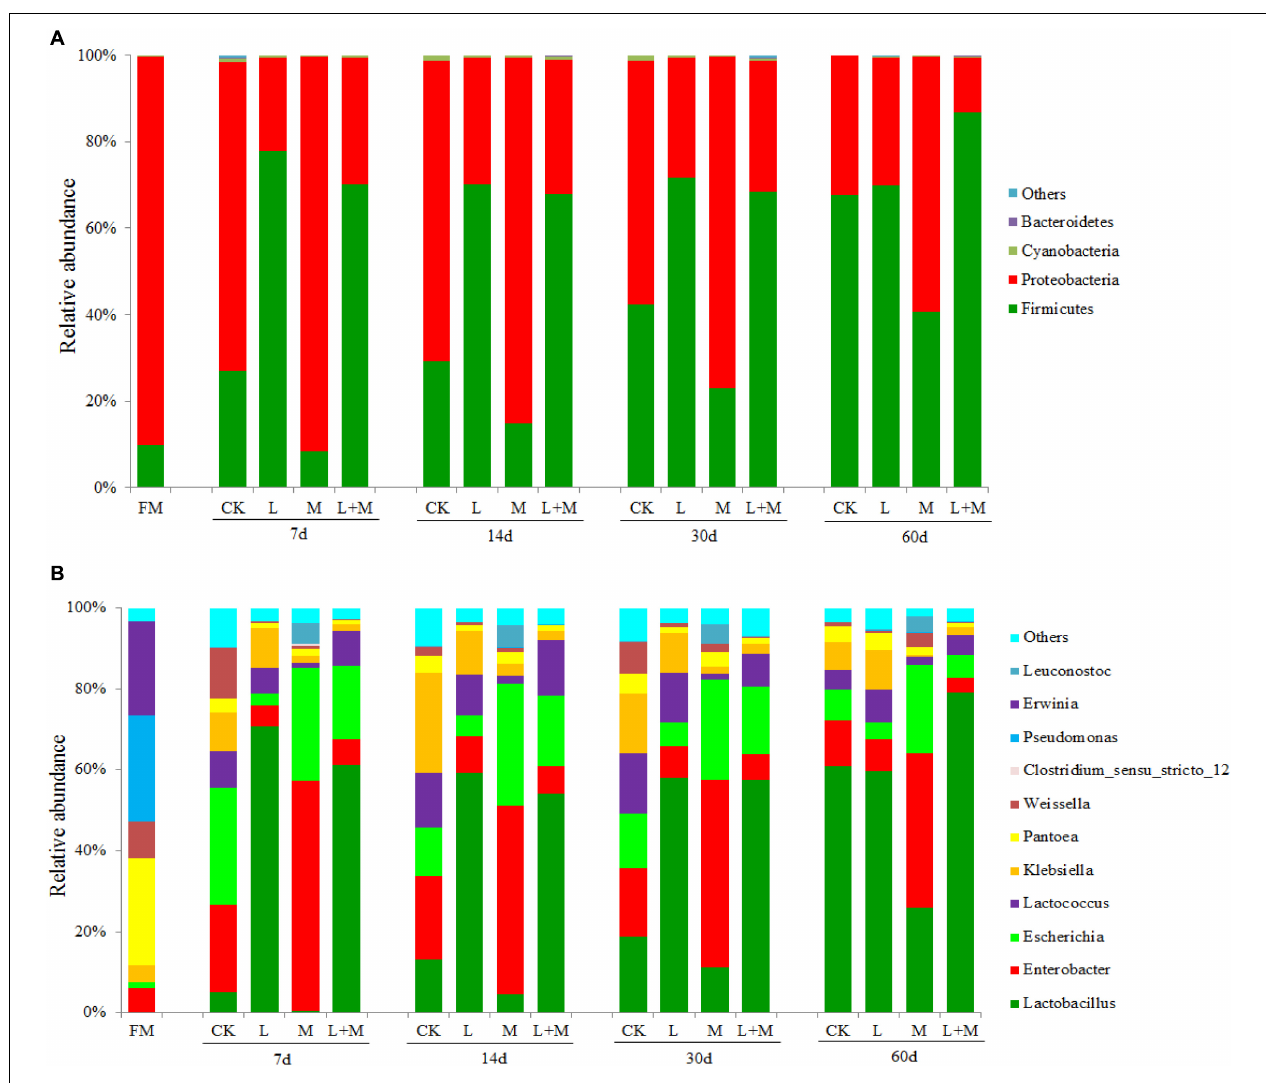
FIGURE 2 | The bacterial abundance at phylum and genus level in native grass silage. FM, fresh material; CK, no additive control; L, lactic acid bacteria; M, molasses; L + M, lactic acid bacteria + molasses. The bacterial communities are shown at the phylum level (A) and the genus level (B)